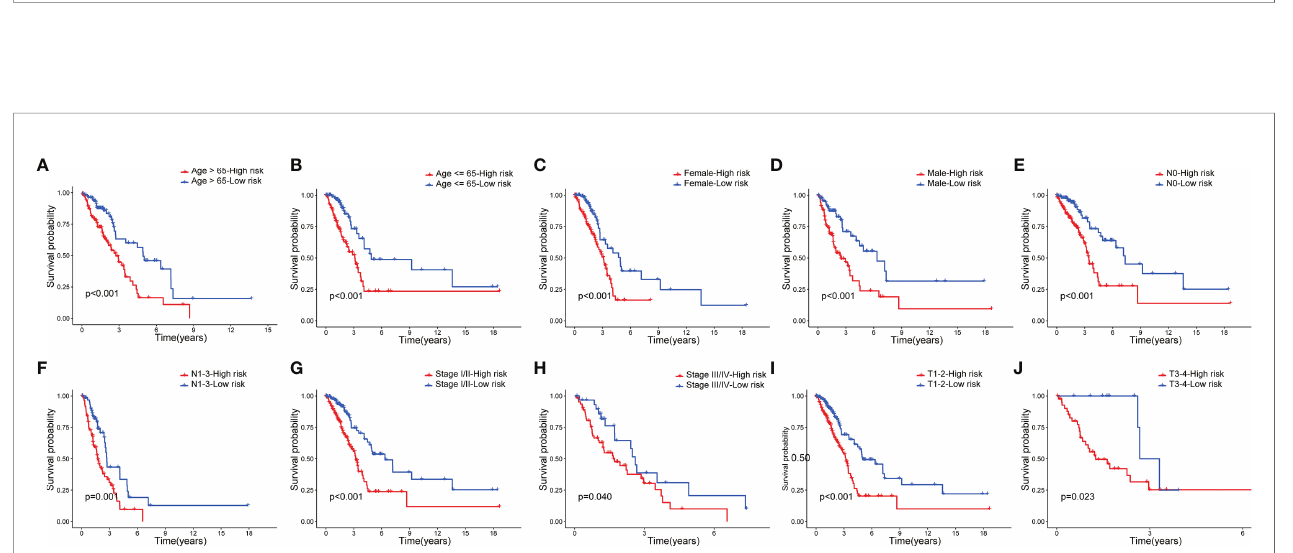
FIGURE 5 | Prognostic analysis of 11-lncRNAs model in the TCGA validation cohort and entire TCGA cohort. (A) Heatmap of 11 pyroptosis-related lncRNAs in the validation cohort. (B) Distribution of survival time and risk scores. (C) Survival analysis in the TCGA validation cohort. (D) ROCs for 1, 3 and 5 year survival time based on the risk score. (E) Survival analysis in the entire TCGA cohort. (F) ROCs for 1, 3 and 5 year survival time based on the risk score.